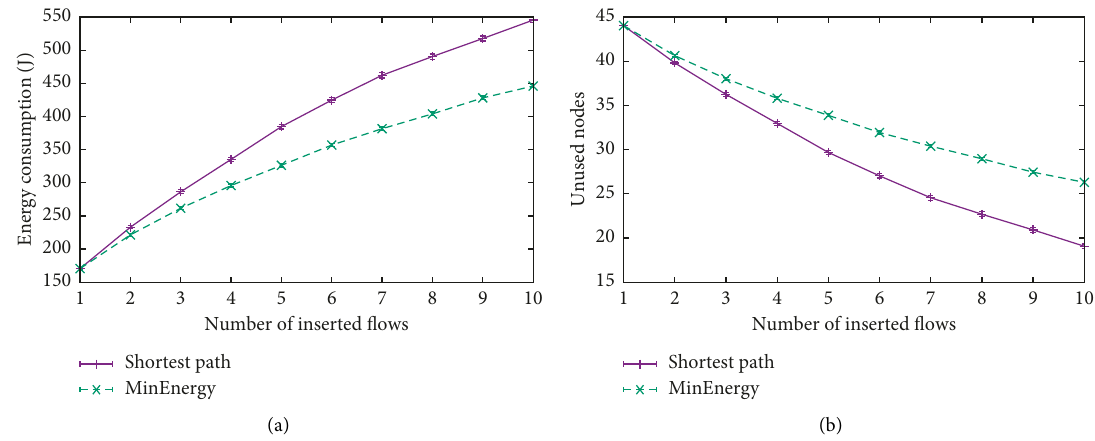
Figure 4: Comparison of a classical shortest path routing and our optimal solution. (a) Overall energy consumption. (b) Number of unused nodes.